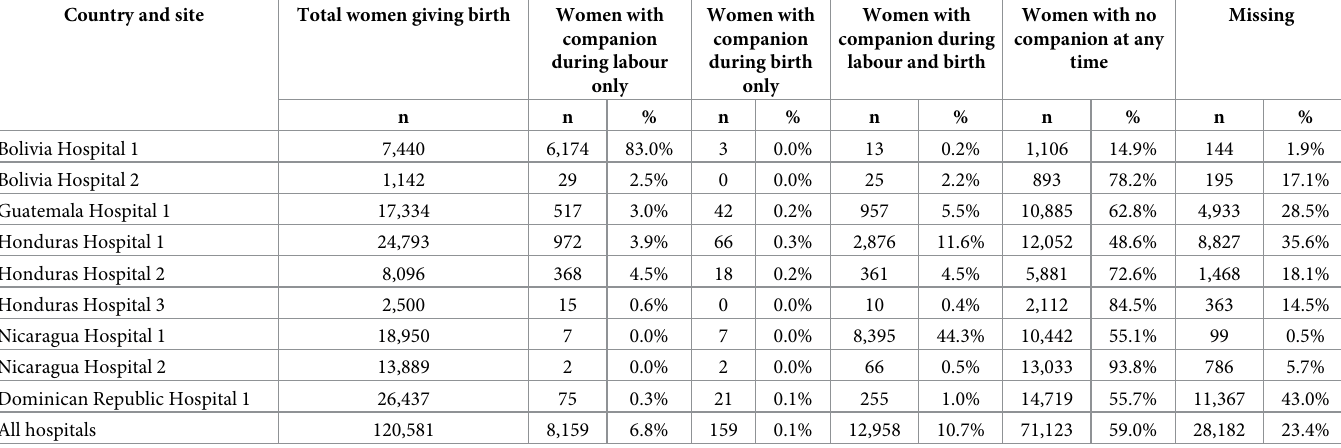
Table 3. Coverage of labour companionship from SIP sentinel data in 9 Latin American hospitals 1 . Country and